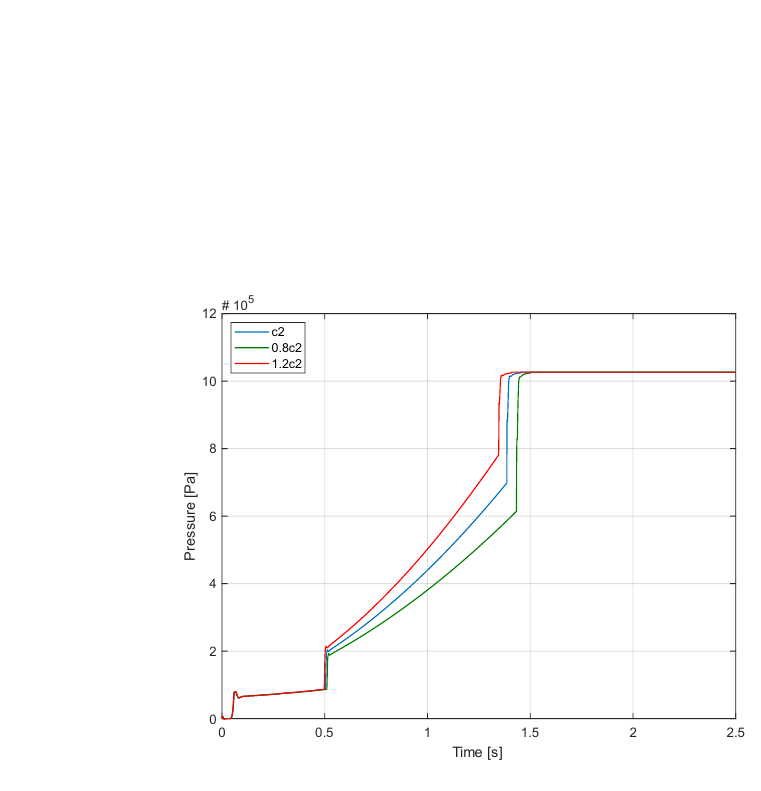
Figure 13 – Influence of the stiffness of the c 2 spring (i) on the pressure modulation process Рис. 13 – Влияние жесткости пружины c 2 (i) на процесс модуляции давления